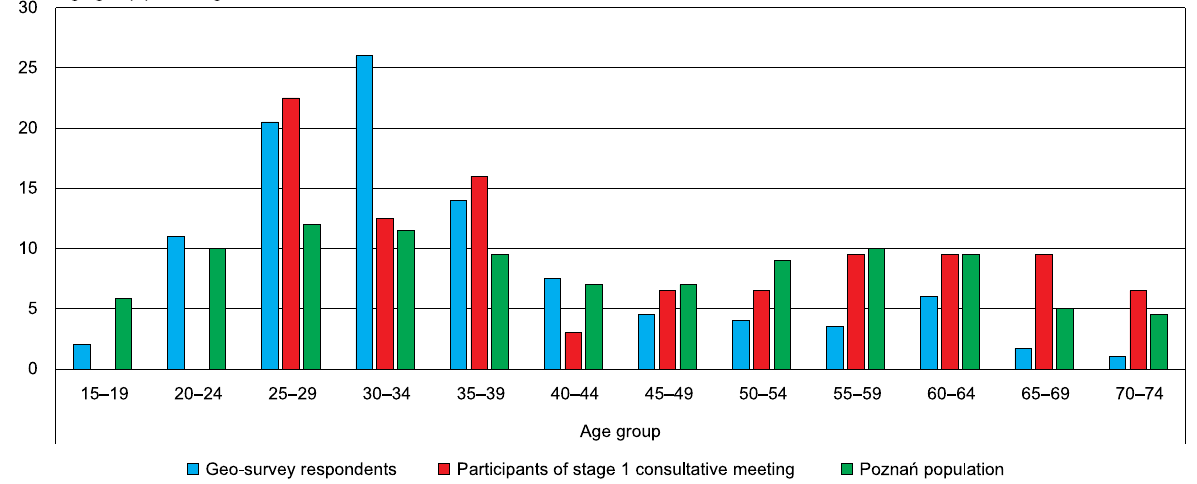
Fig. 7. Age structure of participants of traditional public consultations and Internet consultations. Source: own compilation on the basis of survey